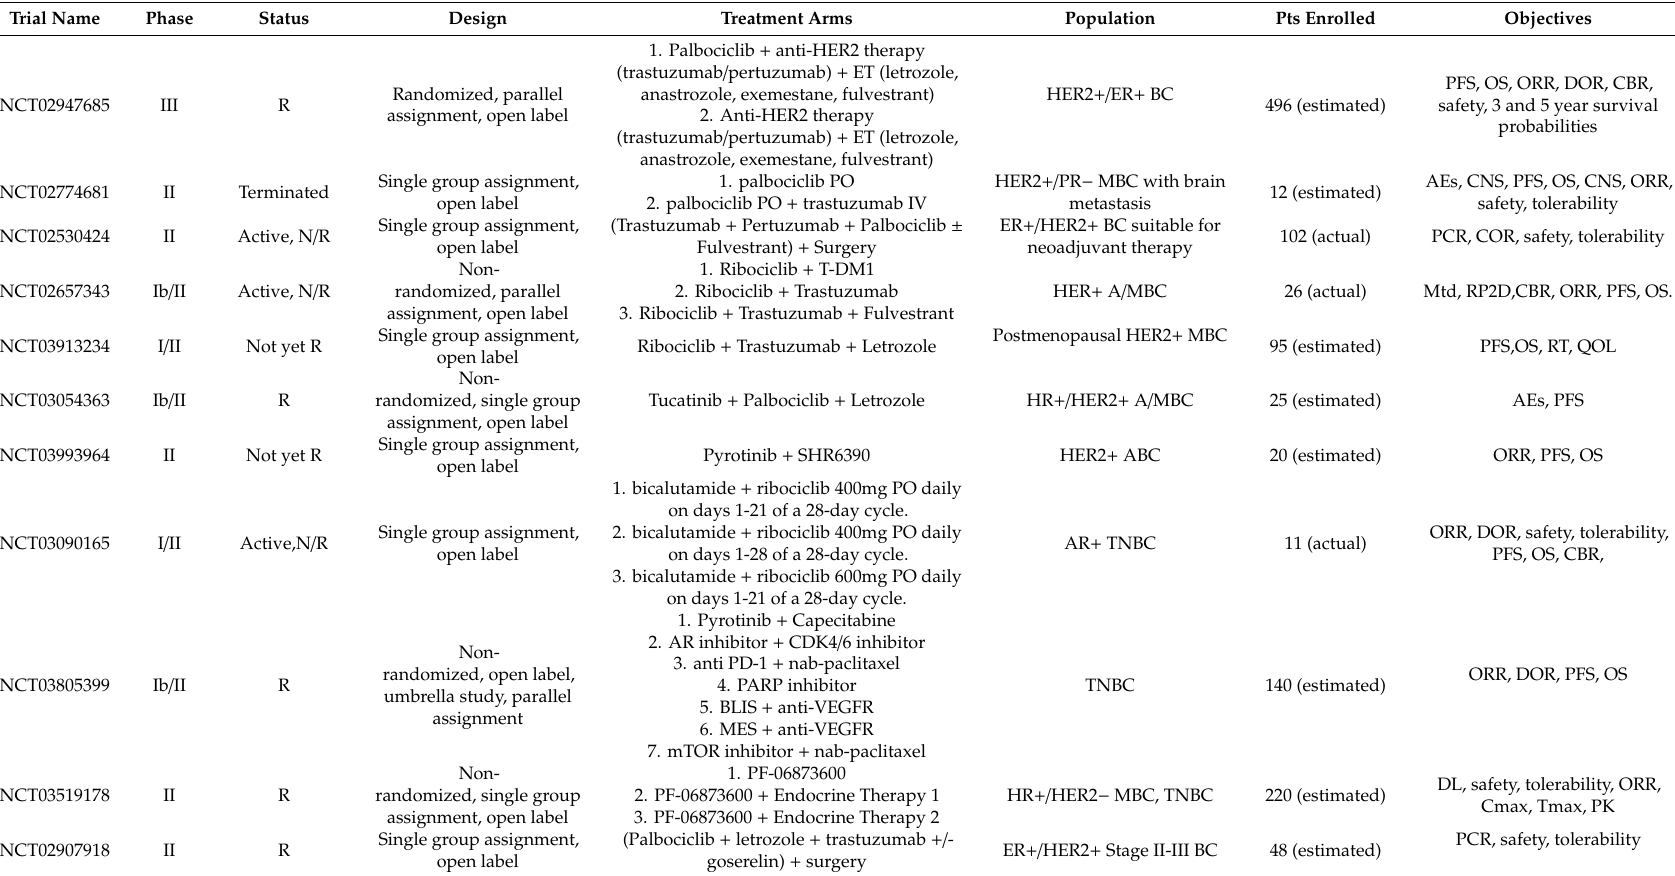
Table 3. Ongoing clinical trials assessing CDK4 / 6 inhibitors for HR +/ HER2 + M / ABC or TNBC